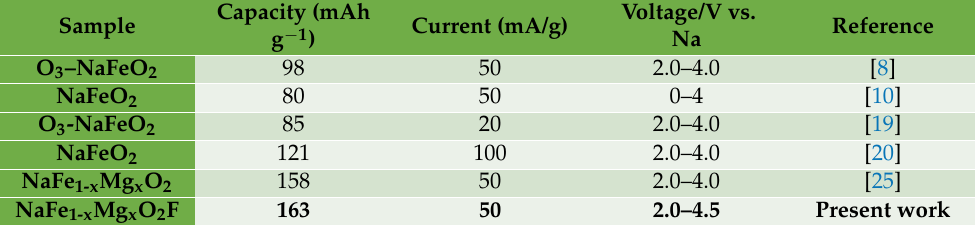
Figure 11. ( a ) EIS analysis before cycling ( b ) EIS analysis after cycling ( c ) equivalent circuit. Figure 11. (a) EIS analysis before cycling (b) EIS analysis after cycling (c) equivalent cir- cuit. Table 3. Comparison with the previous Table 3. Comparison with the previous work.